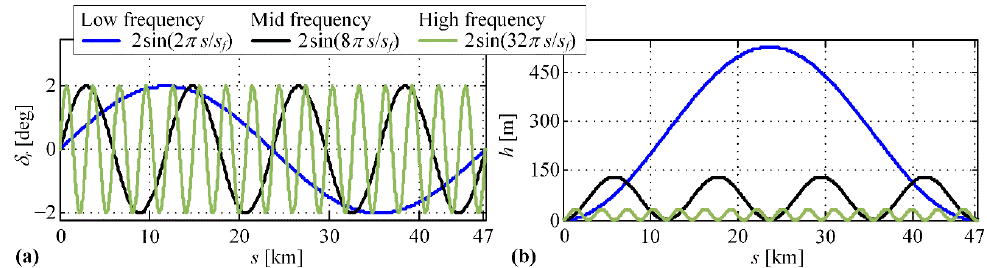
Figure 6. ( a ) Sinusoidal road grade profiles for di ff erent spatial frequencies and s f = 47.3 km and ( b ) corresponding altitude profiles.